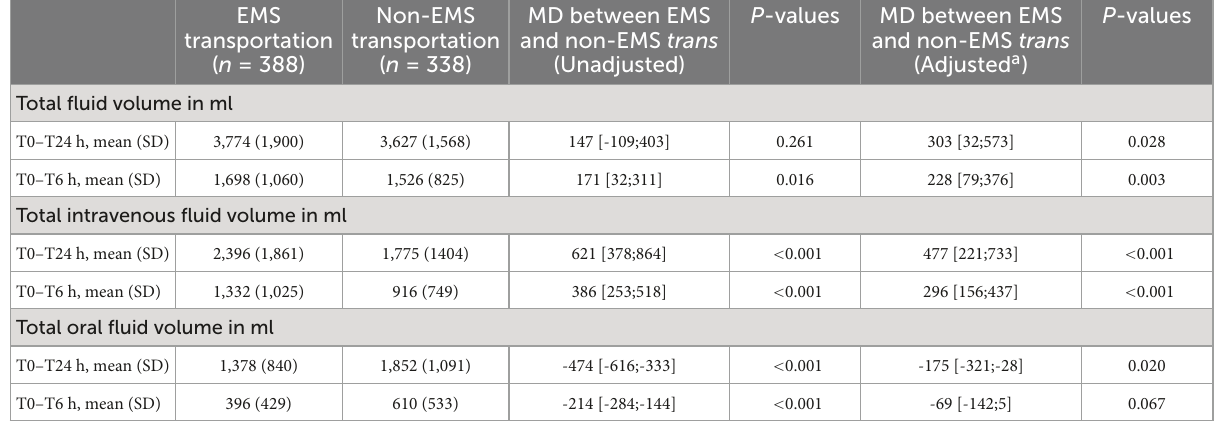
TABLE 4 Fluid administration in the first 24 h stratified by Emergency Medical Services (EMS) or non-EMS transportation for patients with simple infection or sepsis